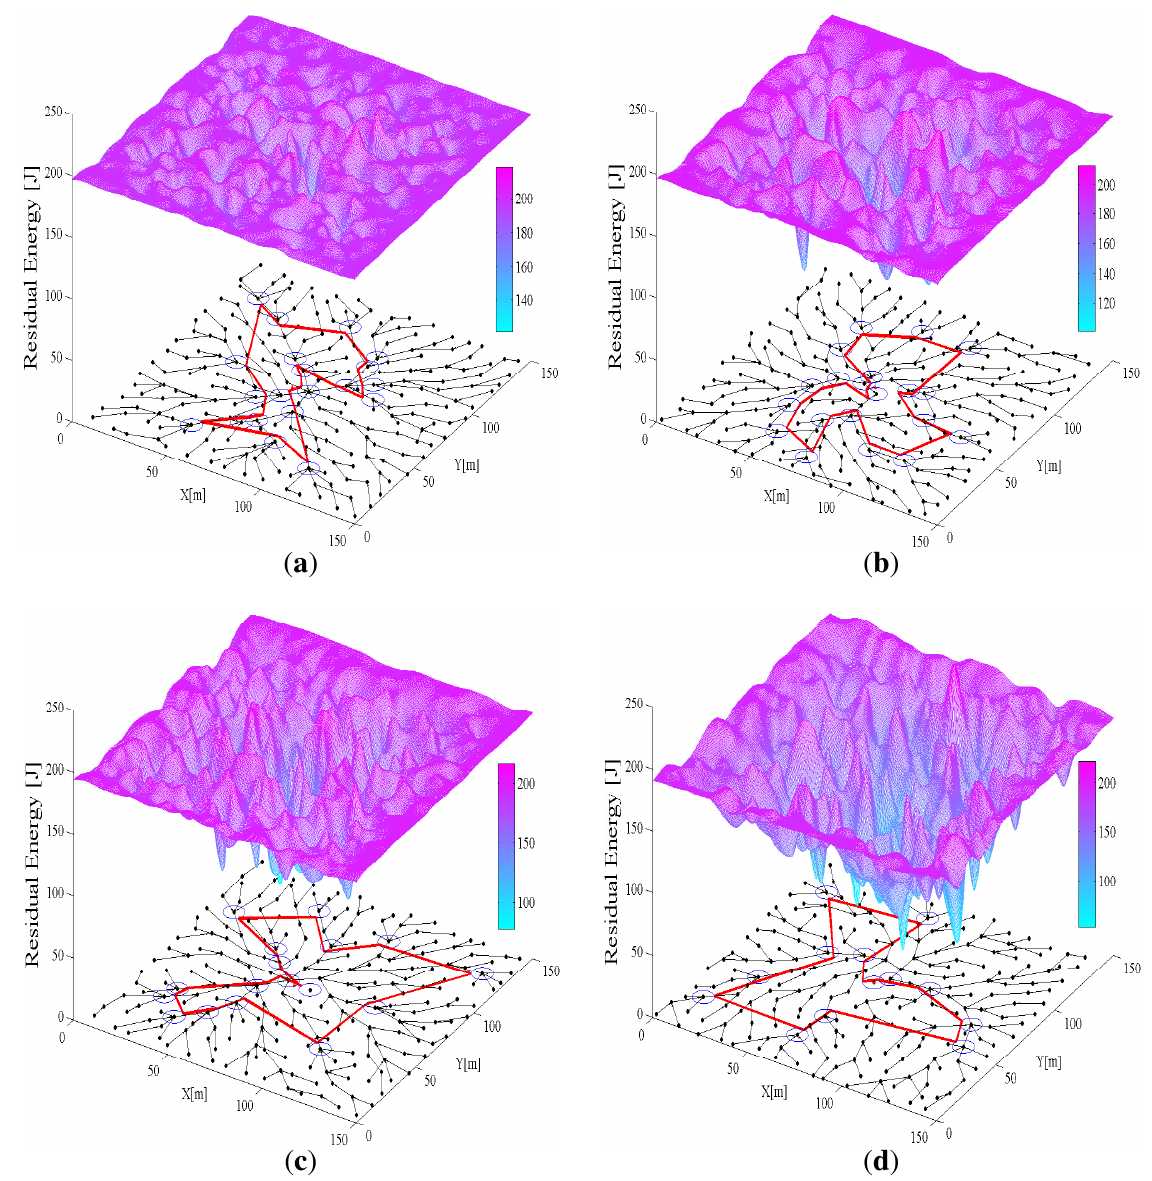
Figure 6. Distribution of network energy consumption with IPA. The x − y plane shows the initial network topology generated by IPA. The 3D surface is fit to the x − y − z data points ( x − y is the 2D coordinate of a node; z is the residual energy of a node). ( a – d ) show the distribution of network energy consumption during the 10th, 50th, 90th and 104th rounds, respectively. ( a ) The distribution of network energy consumption with IPA during the 10th round; ( b ) the distribution of network energy consumption with IPA during the 50th round; ( c ) the distribution of network energy consumption with IPA during the 90th round; ( d ) the distribution of network energy consumption with IPA during the 104th